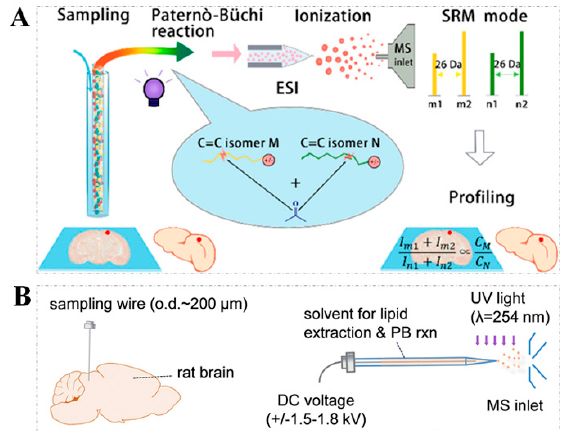
Figure 6. The application examples of typical AIMS techniques in pinpointing C=C locations via PB reaction. ( A ) Direct sampling of tissue section by LMJ-SSP (reproduced permission from Ref. [67]. Copyright (2018) American Chemical Society); ( B ) tissue sampling by a stainless-steel wire (repro- duced from Ref. [68] with permission from Elsevier